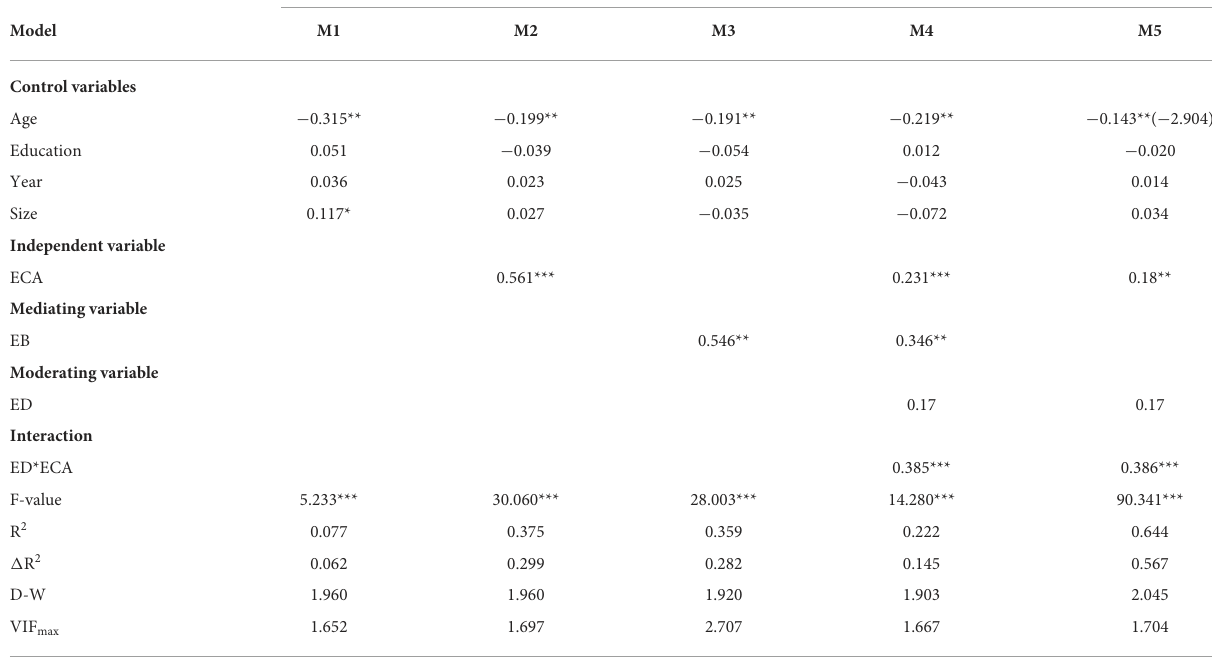
TABLE 3 Hypothesis test results.